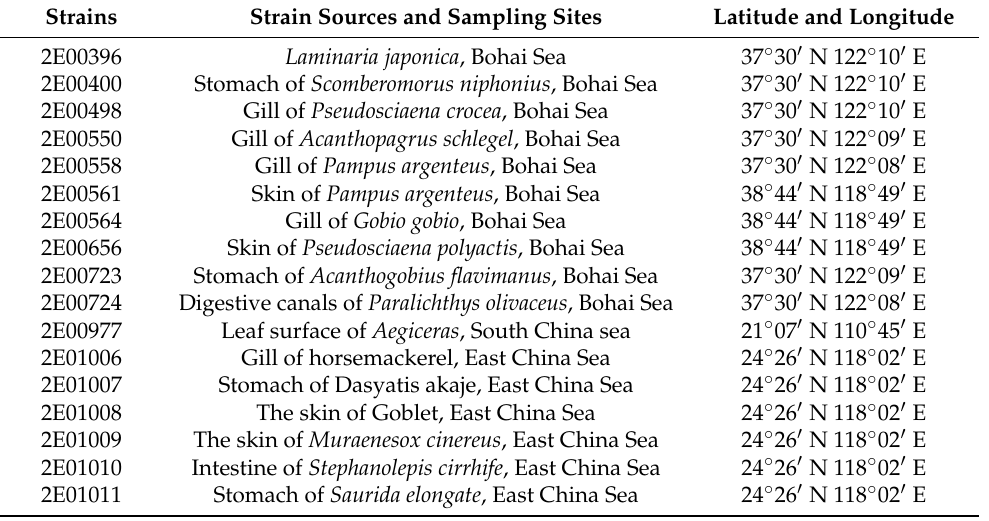
Table 1. The strains of S. cerevisiae isolated from China seas. Strains Strain Sources and Sampling Sites Latitude and Longitude